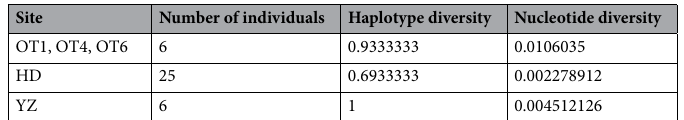
Table 4. Summary of genetic analysis results of Synaphobranchus kaupii within populations.